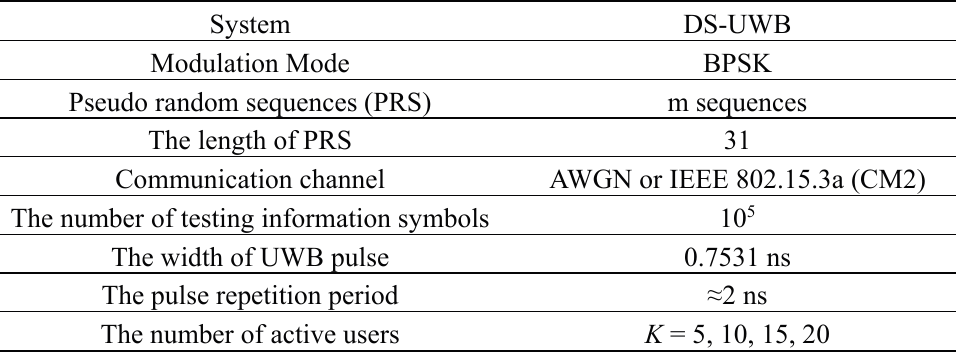
Table 1. Simulation parameters.